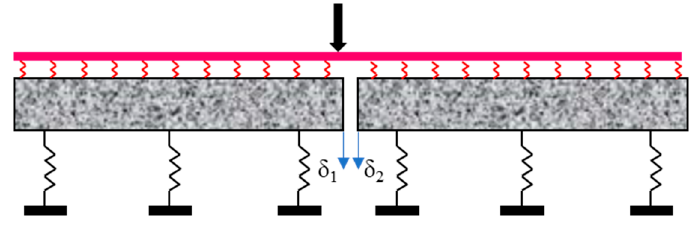
Figure 13. Load transfer between slab panel.